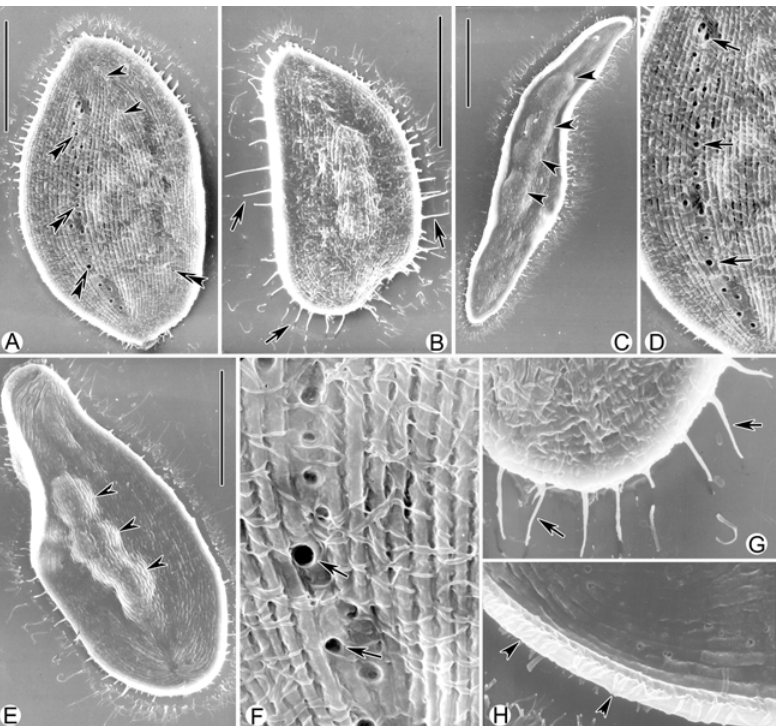
Fig 5. Kentrophyllum qingdaoense sp. n.; photomicrographs of SEM (A – H). A, B. Right lateral views. Arrowheads, suture; arrows, single spine; double-headed arrows, pores of contractile vacuoles. C, E. Left lateral views. Arrowheads, macronuclear nodules. D, F. Right lateral views, indicating the pores of contractile vacuoles (arrows). G. Posterior part of right side, showing single spines (arrows). H. Body margin (arrowheads). Scale bars, 50 μ